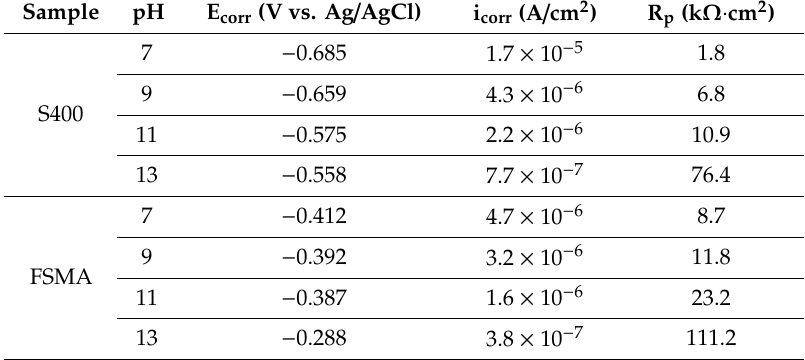
Figure 3. Potentiodynamic polarization curves of ( a ) S400 and ( b ) Fe-based shape memory alloy (FSMA) in 3.5 wt.% NaCl solution with various pH values, adjusted by CaO. Table 3. Estimated free corrosion potential (E corr ), free corrosion current density (i corr ), and polarization resistance (R p ) of S400 and Fe-based shape memory alloy (FSMA) from the potentiodynamic polarization curves in Figure 3.